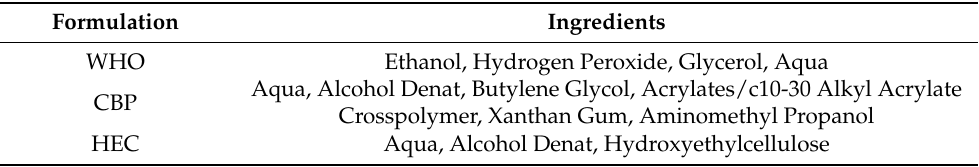
Table 9. Formulations collected for the study design with relative composition. Formulation 1—WHO; Formulation with Carbopol—CBP; Formulation with Hydroxyethylcellulole—HEC. Formulation